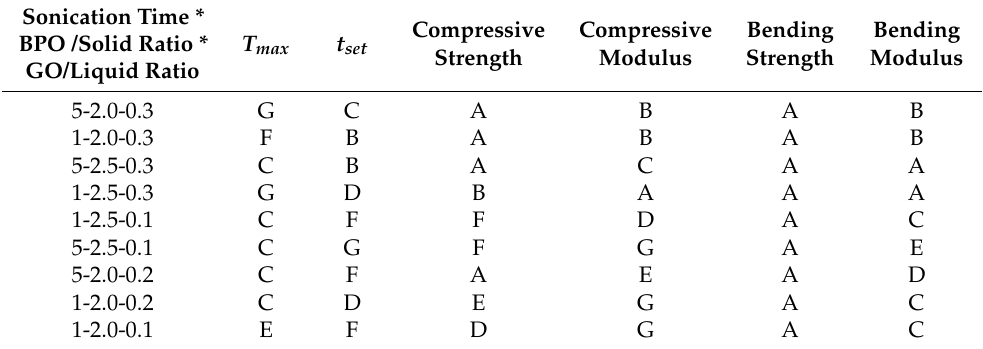
Table 8. Summary of grouping information for T max , t set , compressive strength, compressive modulus, bending strength, and bending modulus for ABCs formulations with higher bending strength. For all properties, the letter A represents the highest values and the letter G the